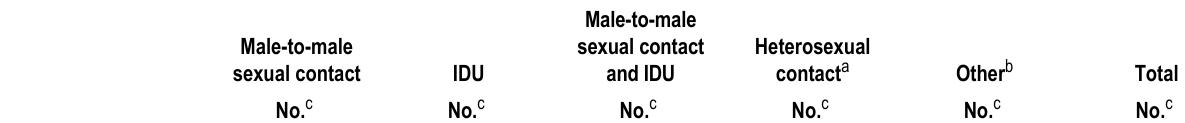
Table 5b. Diagnoses of HIV infection, by transmission category, race/ethnicity, and selected characteristics, 2015—United States and 6 dependent areas